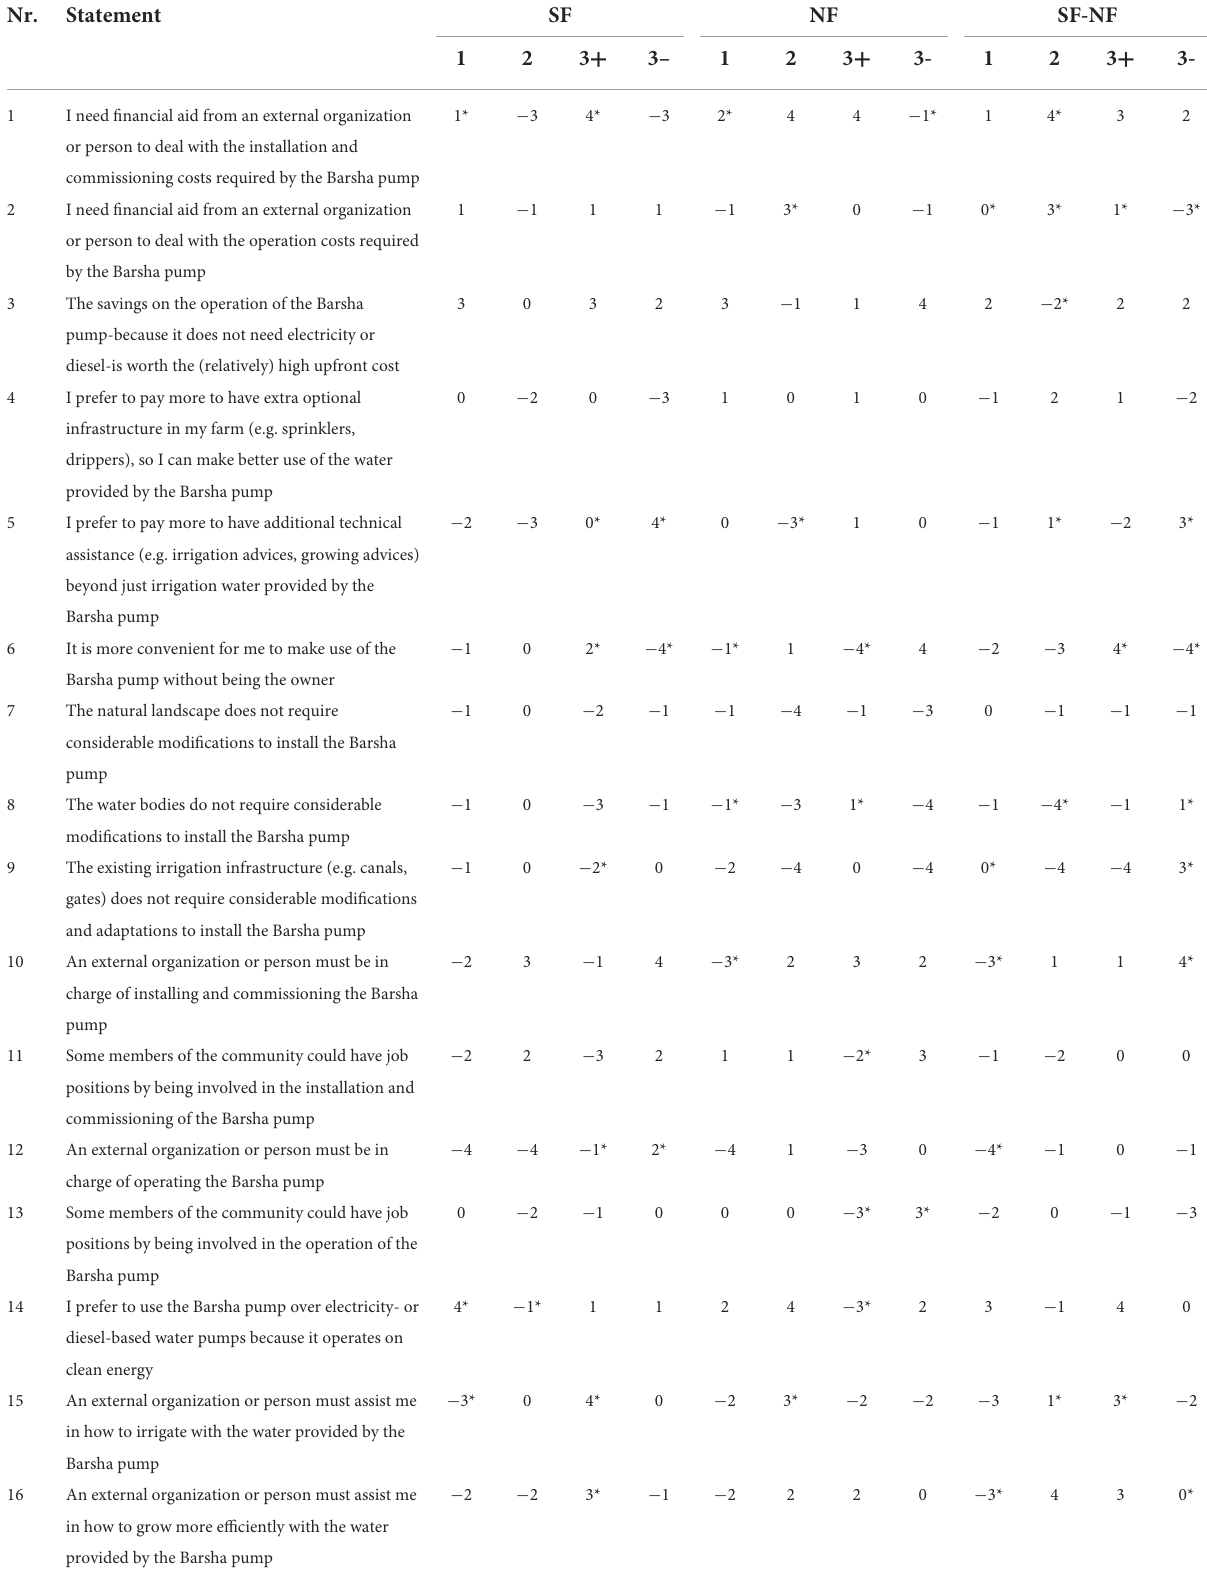
TABLE 7 Raw factor scores of SF, NF and